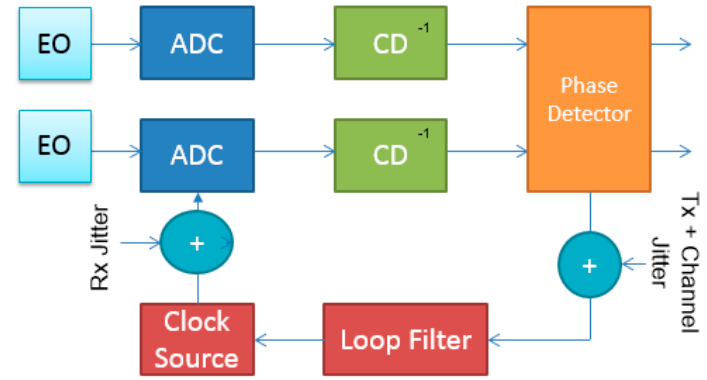
Figure 2. Simplified clock and data recovery schemes used in coherent receivers [8].